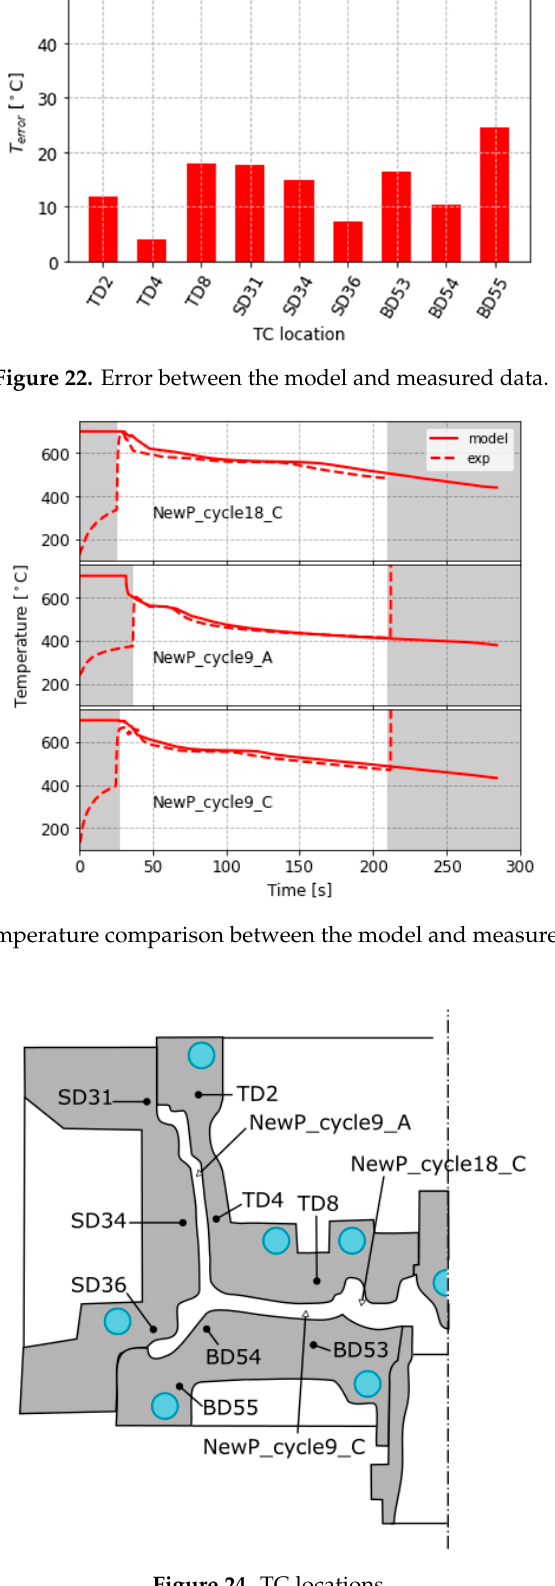
Figure 24. TC Figure 24. TC locations. Figure 24. TC locations.